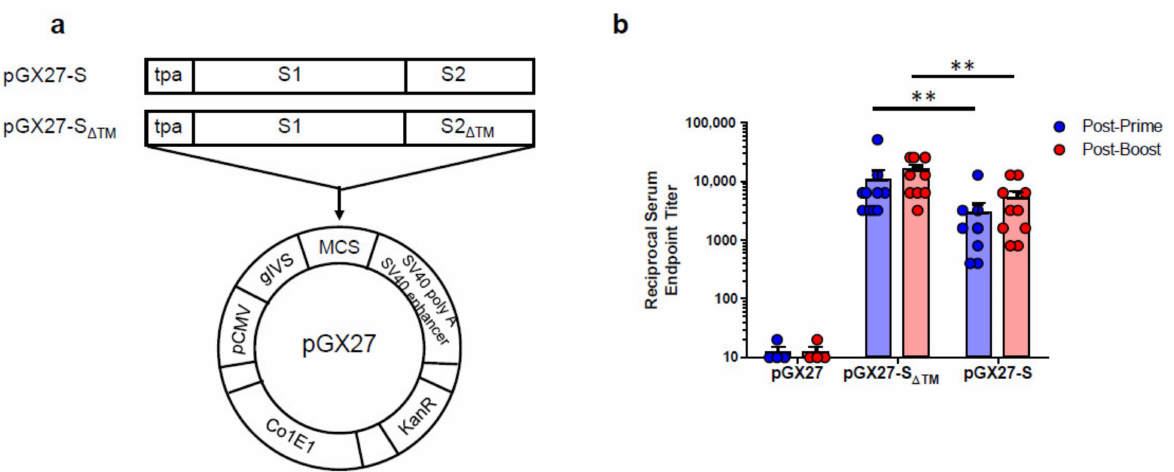
Figure 1. Diagram and immunogenicity of SARS-CoV-2 DNA vaccines. Schematic diagram of COVID-19 DNA vaccine expressing soluble SARS-CoV-2 S protein (S ∆ TM ) or full-length SARS-CoV-2 S protein (S) ( a ). BALB/c mice ( n = 4–10/group) were immunized at weeks 0 and 2 with pGX27-S ∆ TM , pGX27-S, or pGX27 (empty control vector) as described in the Methods. Sera were collected at 2 weeks post-prime (blue) and 2 weeks post-boost (red) and evaluated for SARS-CoV-2 S-specific IgG antibodies ( b ). All data are represented as individual values. ** p < 0.01 as determined by the Mann–Whitney